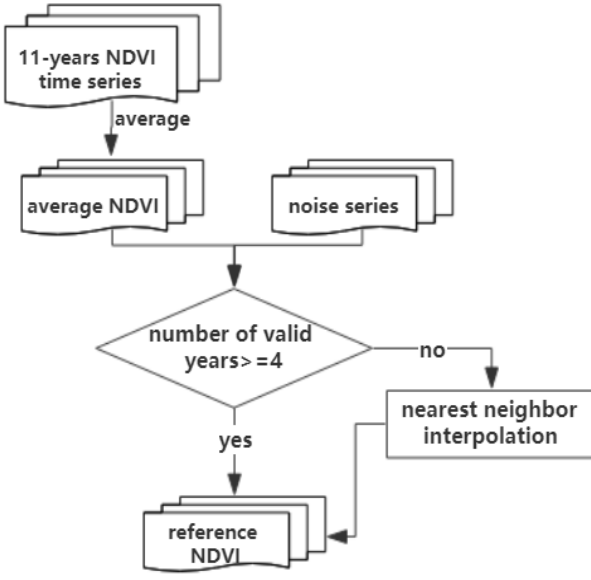
Figure 2. Reference NDVI